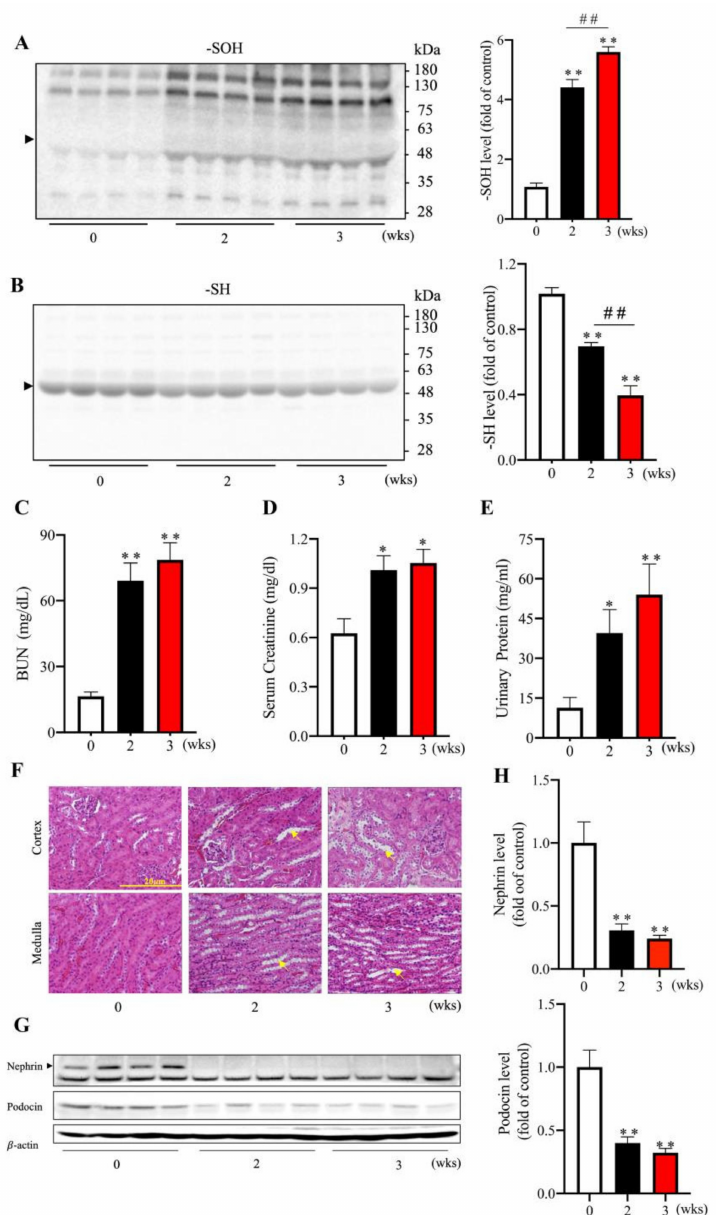
Figure 5. Long-term administration of AA and Cu 2+ on renal structure and functions. ( A , B ) Effects of long-term administration on serum proteins oxidation. Mice were administered 100 mg/kg AA or 1 mg/kg Cu 2+ or both in combination via oral gavage once a day for two and three weeks. Serum was collected and analyzed for the level of -SH groups and -SOH formation. The densitometric quantitation of the bands around 50~60 kDa (arrowhead) was performed and presented as the bar graph on the right side of the blot. Data shown are mean ± SE ( n = 4; ** p < 0.01 vs. control; ## p < 0.01). ( C – E ) Effects of AA plus Cu 2+ on renal functions. The level of BUN, creatinine and urinary proteins were measured. The data shown are mean ± SE ( n = 4–8; * p < 0.05; ** p < 0.01 vs. control). ( F – H ) The effect of AA plus Cu 2+ on renal histopathological changes and podocyte injury markers. Representative images of HE staining of the kidney are shown in ( F ). Note that AA plus Cu 2+ destroyed the intact epithelial architecture, including the loss of brush border, detachment of epithelial cells, and tubular cell vacuolation (arrow). The effect of AA plus Cu 2+ on the podocyte injury markers nephrin and podocin is shown in ( G , H ). Data shown in ( H ) are mean ± SE ( n = 4; ** p < 0.01 vs.